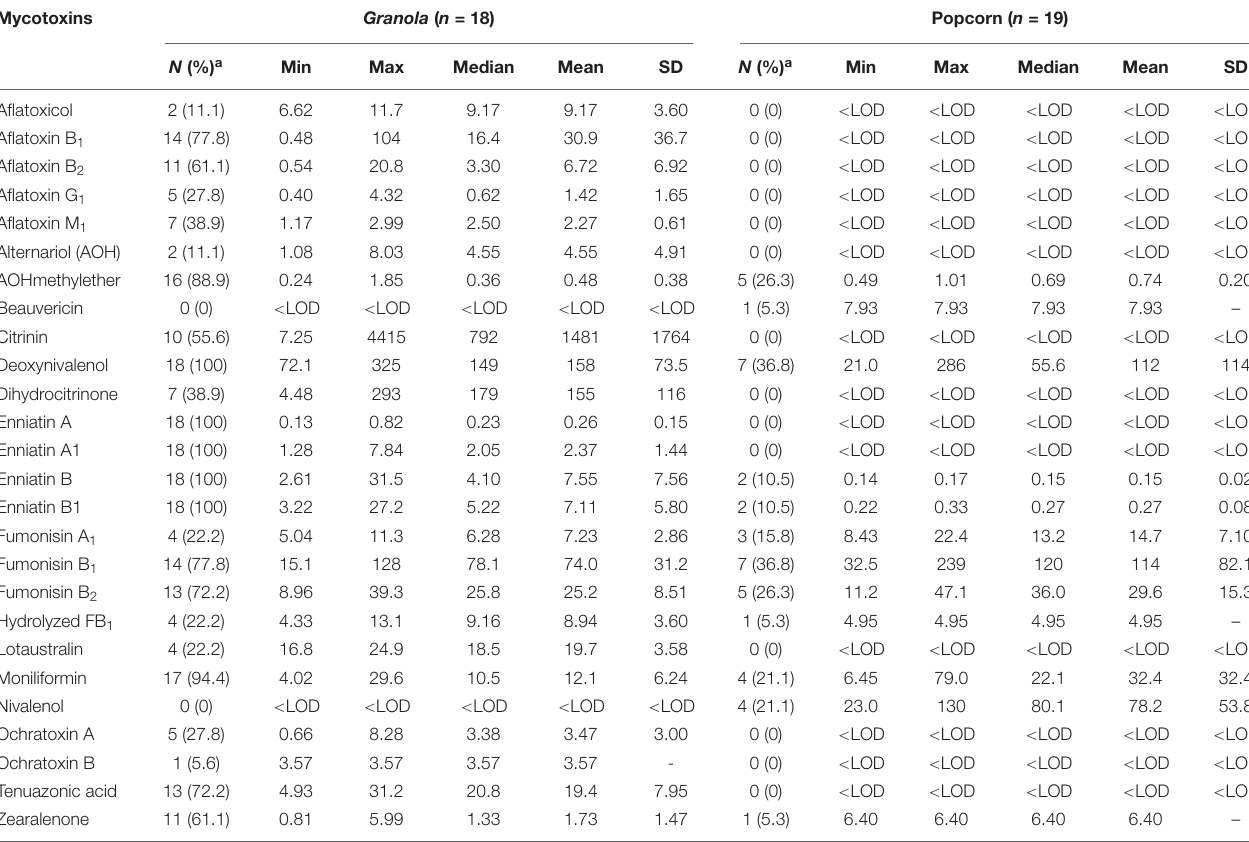
TABLE 3 | Occurrence of 26 mycotoxins and cyanogenic glucosides in dried cereal-based ready-to-eat foods from Ogun state, Nigeria. Mycotoxins Granola ( n = 18)